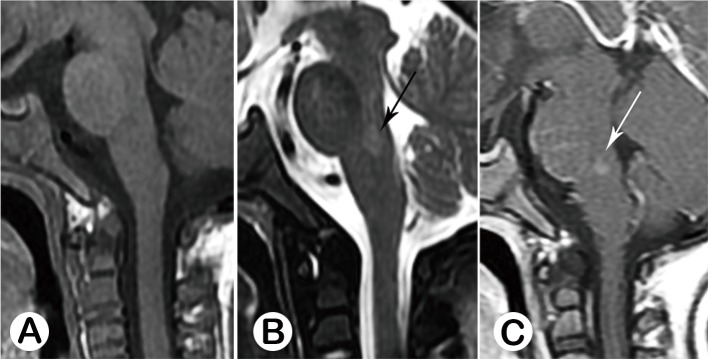
Acute stage type Ⅱ.Male 20 months old. Sagittal T1WI (A) appeared normal. A patchy lesion with prolonged T2 signal was revealed on sagittal T2WI (B, black arrow), with mild enhancement (C, white arrow).